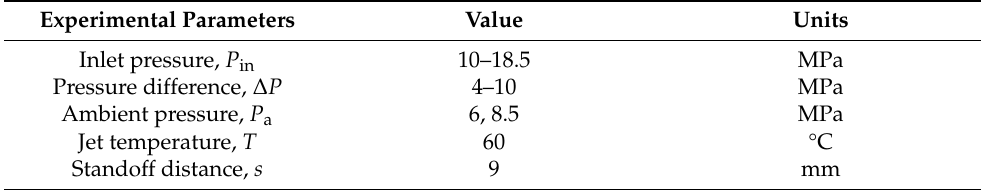
Table 4. Experimental conditions in this Figure 3. Schematic diagram of the organ pipe nozzle.